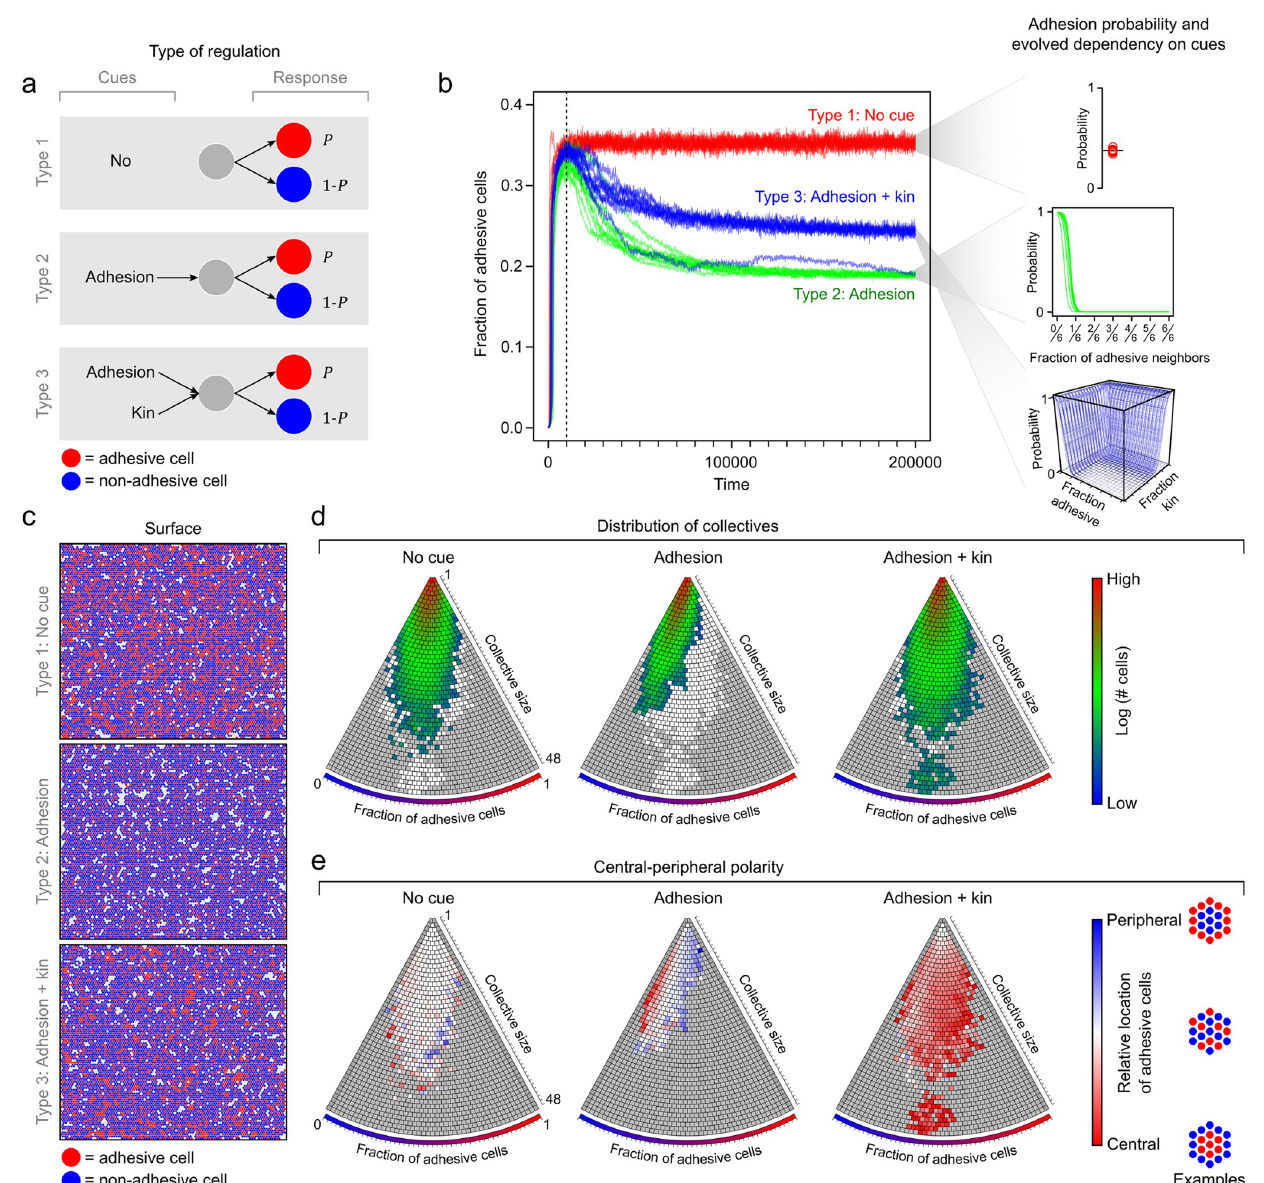
Fig 3. Type of regulation profoundly impacts evolution of cell collectives. (a) Schematic depiction of 3 idealized types of regulation. Cues that cells sense and the probability that cells become adhesive ( P , red) or nonadhesive (1 − P , blue). (b) Left, fraction of adhesive cells in population over evolutionary time ( n = 10; see also S6 Fig): red, type 1; green, type 2; blue, type 3. (b) Right, evolved dependency of adhesion probability on environmental cues ( n = 10). (c) Surface at the end of evolution. (d) Distribution of collectives according to their size and the fraction of adhesive cells within the collective: grey, collectives that are never observed; white, collectives that are observed in other regulatory systems; color, log-transformed number of cells that are associated with observed collectives. (e) Central-peripheral polarity in cell adhesion: red, adhesive cells are localized closer to center than nonadhesive cells; blue, nonadhesive cells are localized closer to center than nonadhesive cells; white, no difference between localization of adhesive and nonadhesive cells. Note, since localization of adhesive cells is determined relative to that of nonadhesive cells, polarity can only be established for collective with both adhesive and nonadhesive